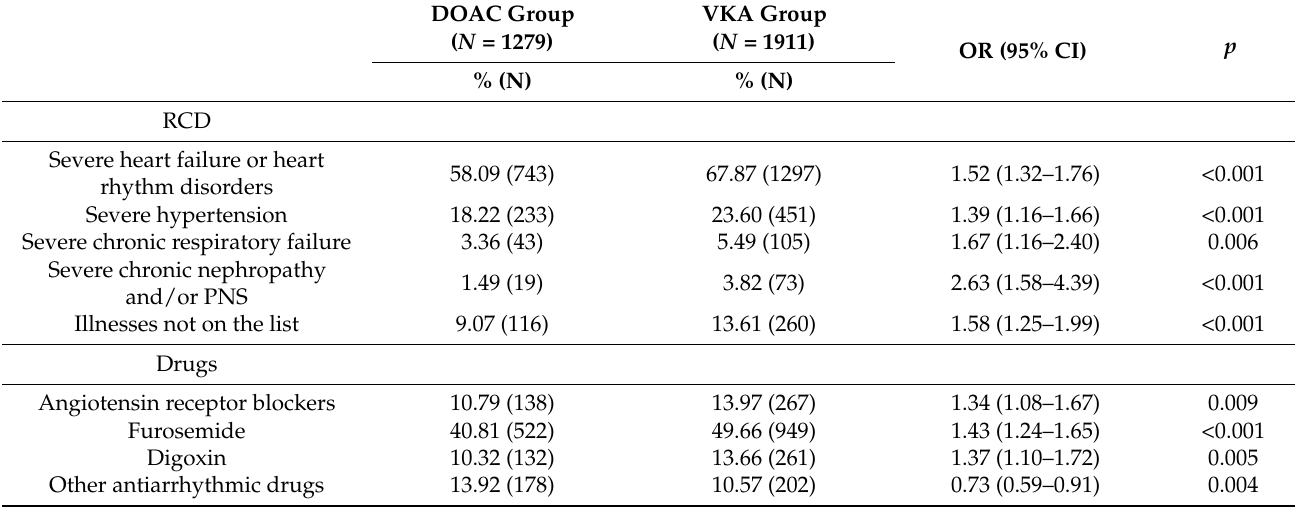
Table 2. Comparison of registered chronic diseases and cardiovascular medications between subjects with direct oral anticoagulants and those with vitamin K antagonists, using bivariate analysis by logistic regression. Only significant differences are reported.